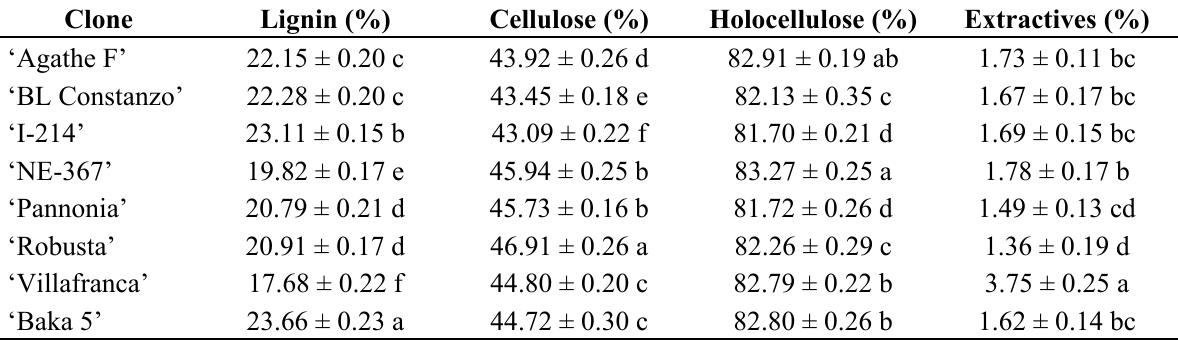
Table 1. The content of main wood components and extractives present in the examined clones of Populus grown on the Sliepkovce experimental site. Data represent percentages of oven dry weight (odw) (mean ±